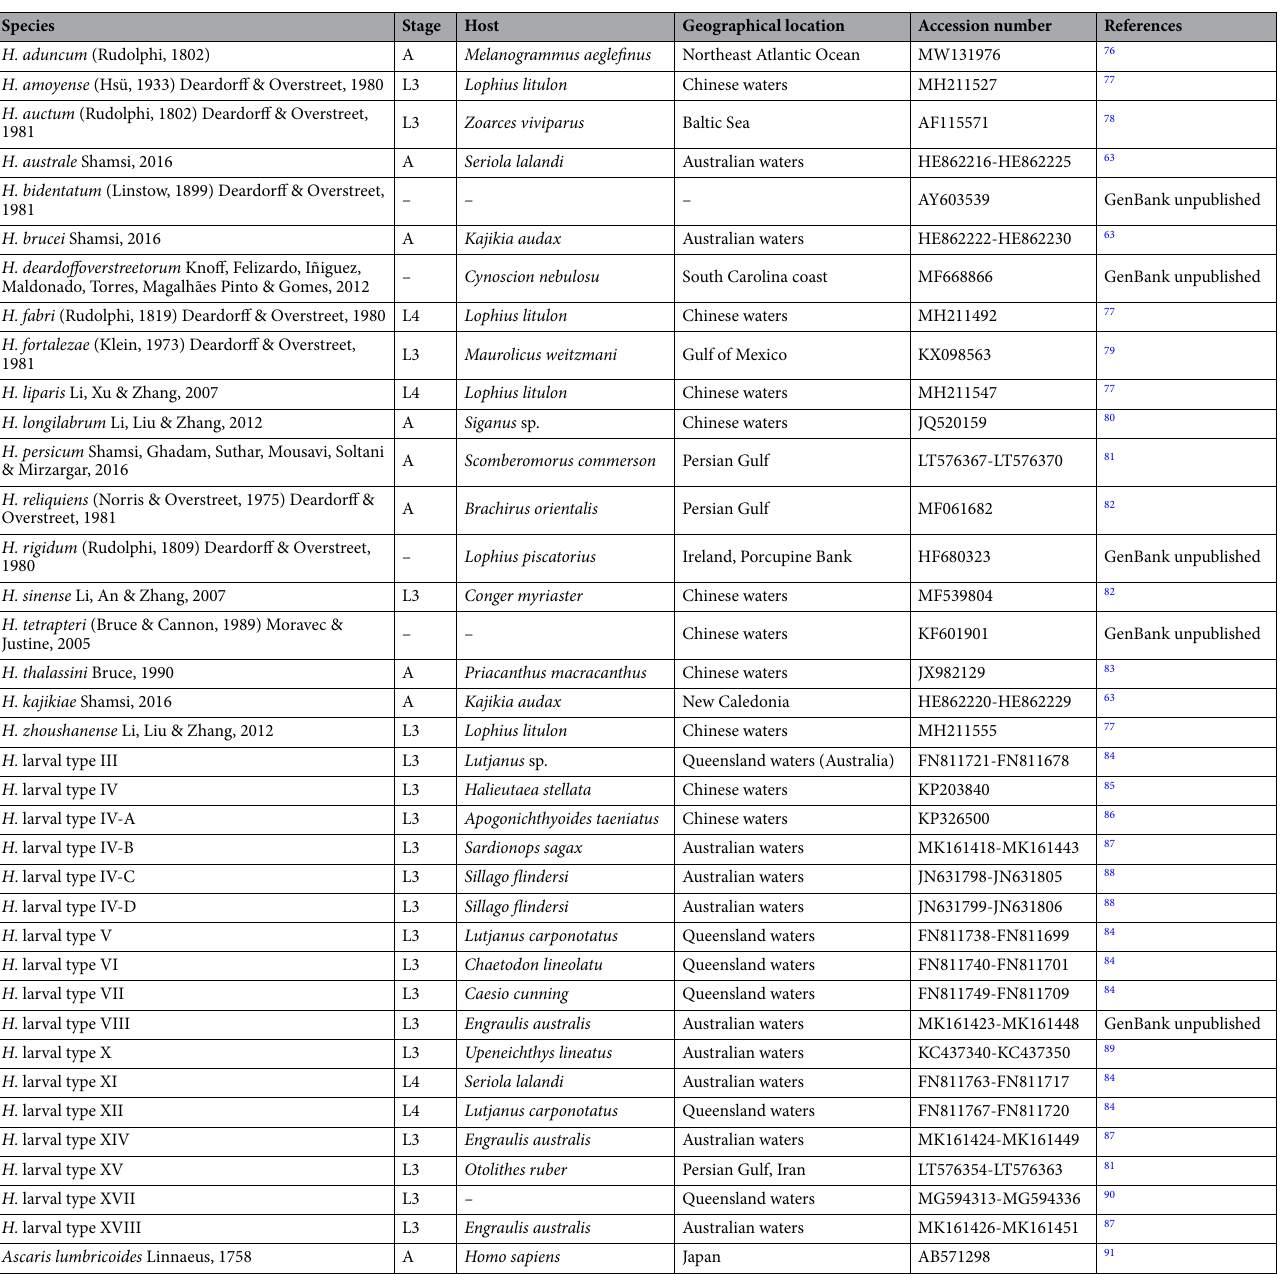
Table 1. Species, stage (A: adult, L4: fourth larval stage, L3: third larval stage), host, geographical location, and accession number of sequences of ITS rDNA of Hysterothylacium species included in the Bayesian inference shown in Fig. 2. (–: data not